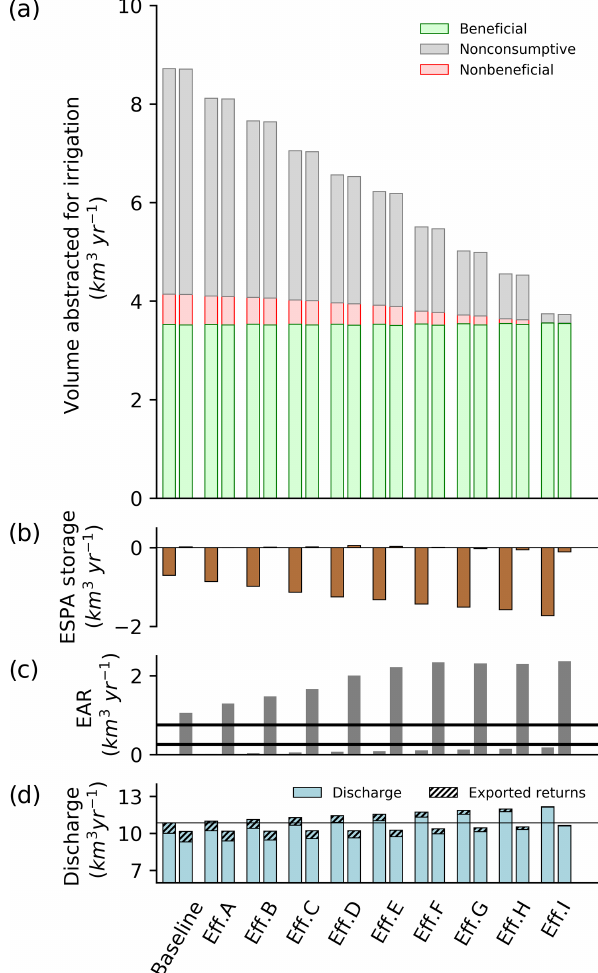
Figure 3. (a) Critical water fluxes across efficiency scenarios paired by simulations without (left) and with (right) enhanced aquifer recharge (EAR). Component fractions of gross irrigation water for the USRB as 2008–2017 averages. (b) Average change in volume of the ESPA. (c) Enhanced aquifer recharge (recharge to the ESPA upstream of the American Falls) required to stabilize the aquifer water balance. Horizontal lines represent the target (0.26km 3 yr − 1 ) and feasible (0.75km 3 yr − 1 ) bounds on existing managed aquifer recharge practice and infrastructure (IWRB, 2016). (d) Discharge and exported incidental returns at the watershed outlet at King Hill, Idaho. The horizontal line indicates the average discharge at the